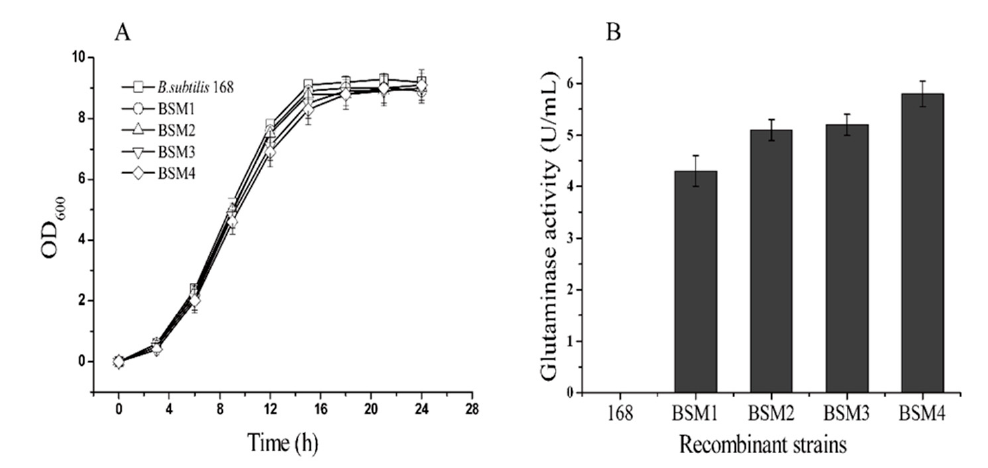
Figure 2. Shake flask fermentation analysis of recombinant strains and B. subtilis 168. ( A ) Growth curves of the recombinant and B. subtilis 168 strains. The values shown are the average of three independent measurements and are presented as the error bars; ( B ) the maximum glutaminase activity of the recombinant strains and B. subtilis 168 produced by fermentation. The wild-type B. subtilis 168 strain was used as a negative control. The standard errors are calculated from three independent biological experiments.